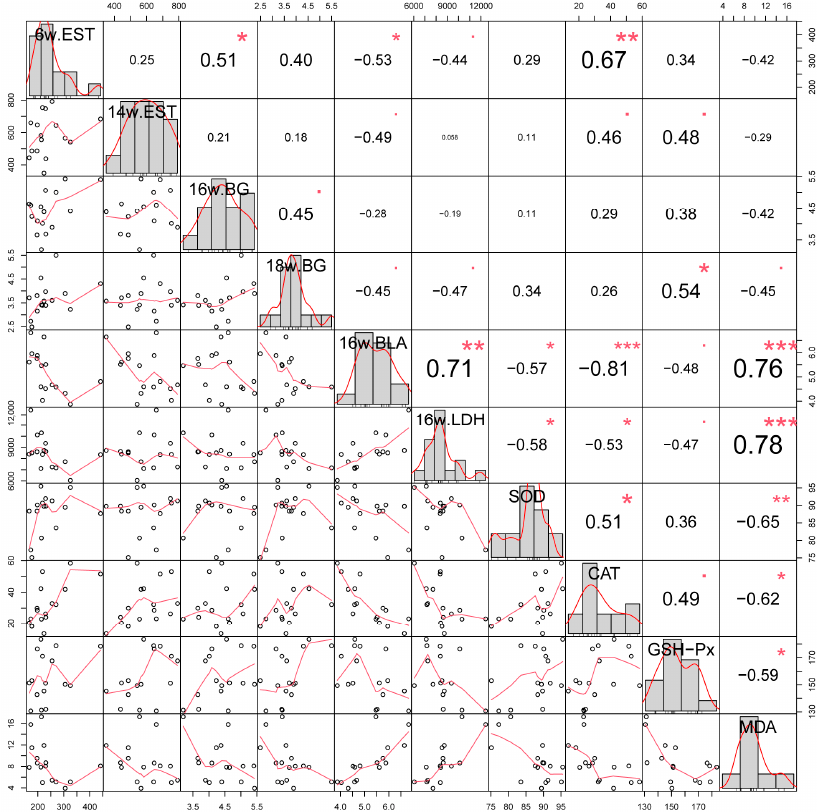
Figure 3. Pearson correlation analysis of different indicators of mice. 6w. EST: exhaustive swimming time at 6 weeks; 14w. EST: exhaustive swimming time at 14 weeks; 16w. BG: blood glucose after free swimming test at 16 weeks; 18w. BG: blood glucose at 18 weeks; 16w. LDH: lactate dehydrogenase after free swimming test at 16 weeks; SOD: superoxide dismutase at 18 weeks; CAT: catalase at 18 weeks; GSH-Px: glutathione peroxidase at 18 weeks; and MDA: malondialdehyde at 18 weeks. All biochemical indices are measured from blood serum. The red line at the bottom half of the plot is the fitted curve. The red line in the diagonal of the plot is the probability density function. Significant correlations are indicated by * p < 0.05, ** p < 0.01, and *** p < 0.001.